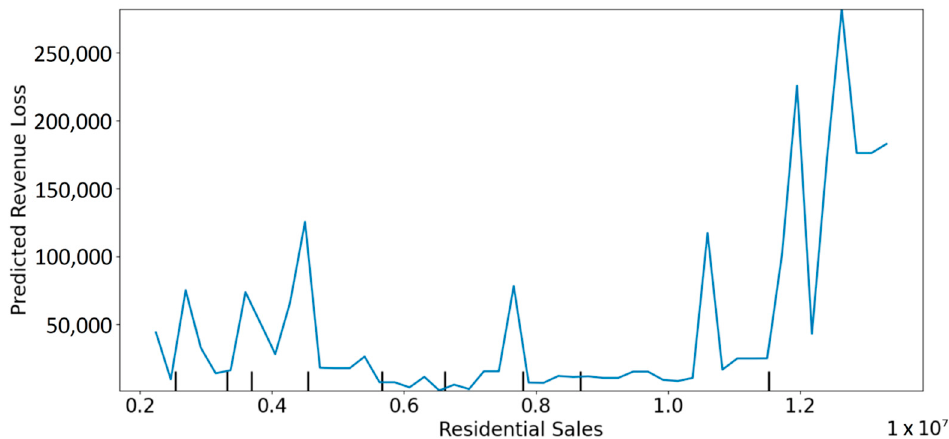
Figure 19. Influence of residential sales parameter on revenue loss.